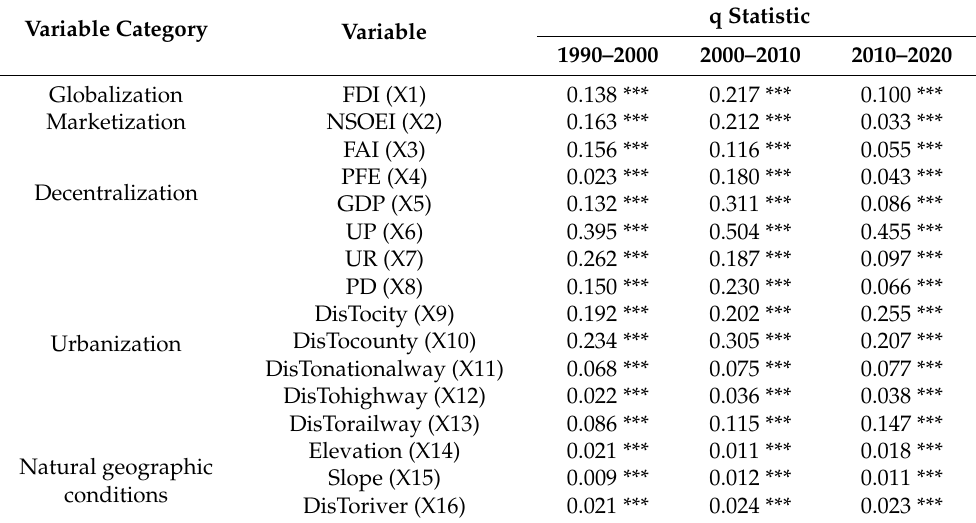
Table 3. Detection results of impact factors of urban construction land in Nanchang. Variable